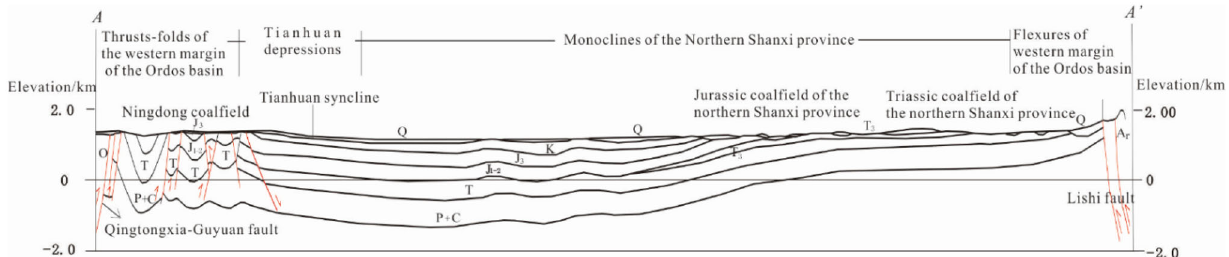
Fig. 6 Structural profile of the E–W trending A – A 0 cross section in the Ordos Basin (section position see Fig.